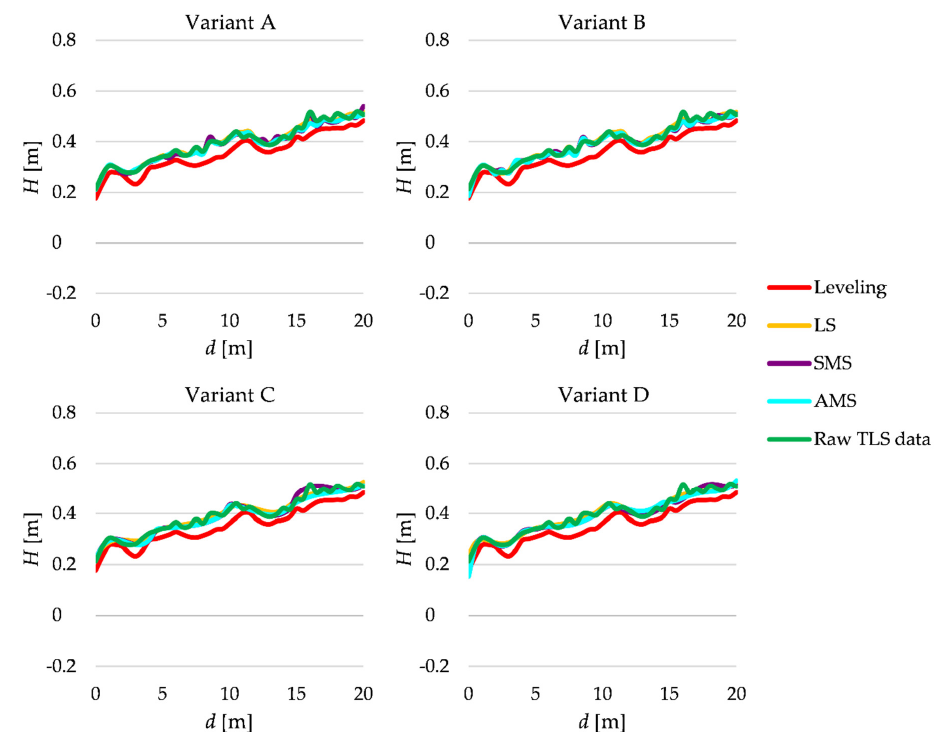
Figure 12. Estimated terrain profiles of line III.